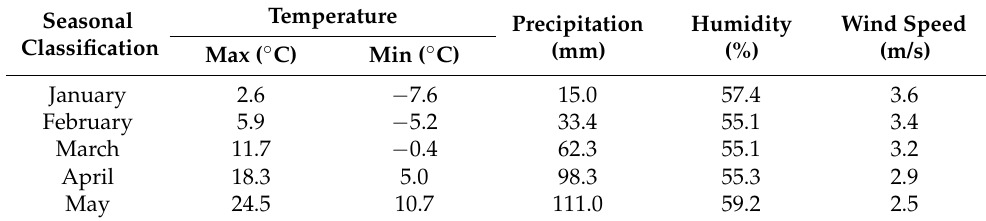
Table 1. Result weather information construction of Yecheon Basin Area. Seasonal Classification